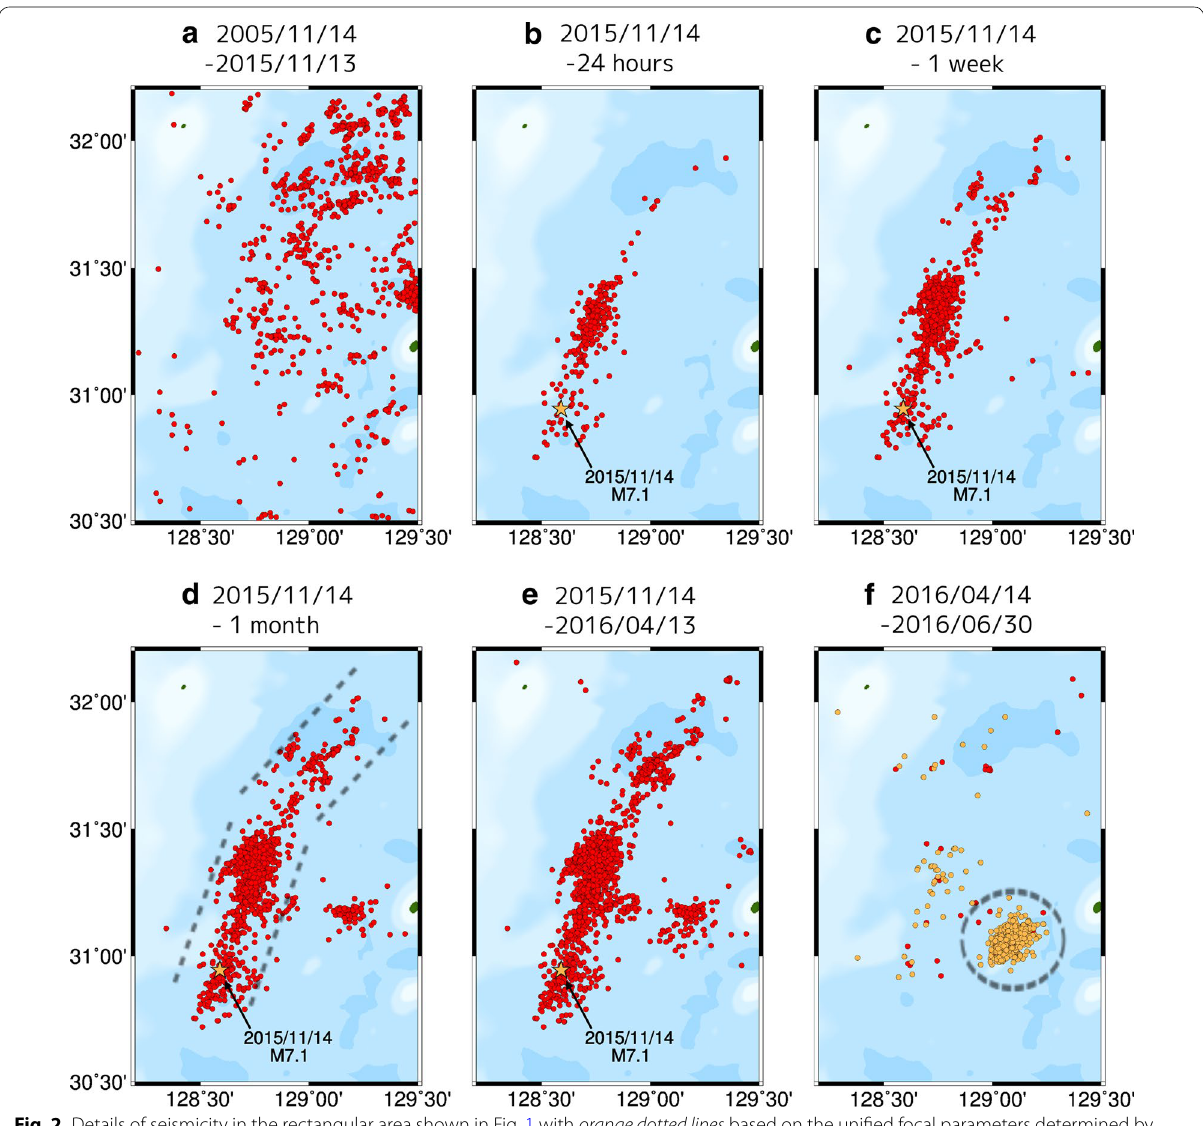
Fig. 2 Details of seismicity in the rectangular area shown in Fig. 1 with orange dotted lines based on the unified focal parameters determined by JMA: a distribution of the earthquakes ( M JMA 2 and depths 30 km) from 11/14/2005 to 11/13/2015 (JST), i.e., 10 years prior to the 11/14/2015 ≥ ≤ M7.1 event. b Twenty-four-hour aftershocks of the M7.1 event (EV1). c One-week aftershocks of EV1 from 11/14/2015 to 11/20/2015 (JST). d One- month aftershocks of EV1 from 11/14/2015 to 12/13/2015 (JST). e Activity from 11/14/2015 to 04/13/2016 (JST), i.e., just before the onset of the Kumamoto earthquake sequence. f Activity from 04/14/2016 to 06/30/2016 (JST), i.e., after the onset of the Kumamoto seismic activity. The events beginning with a M5.0 event on 05/06/2016 (Fig. 3a) are drawn with orange